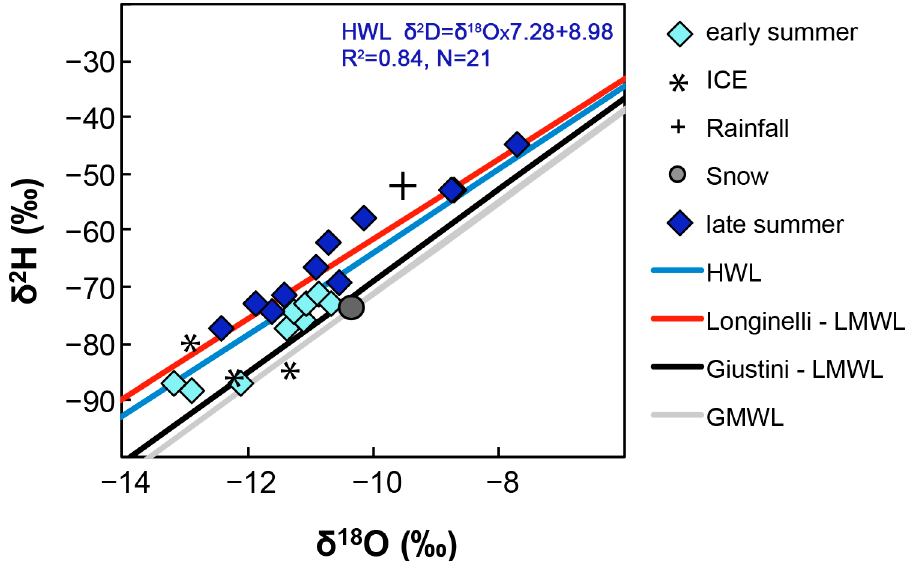
Figure 4. Isotopic composition of stream waters in the two sampling seasons described in the previous chapter, as well as precipitation and ice. Meteoric water lines (grey line [56], black line [57], and red line [62]) are also reported. Headwater Line (HWL) headwater regression line was calculated considering all samples from streams.